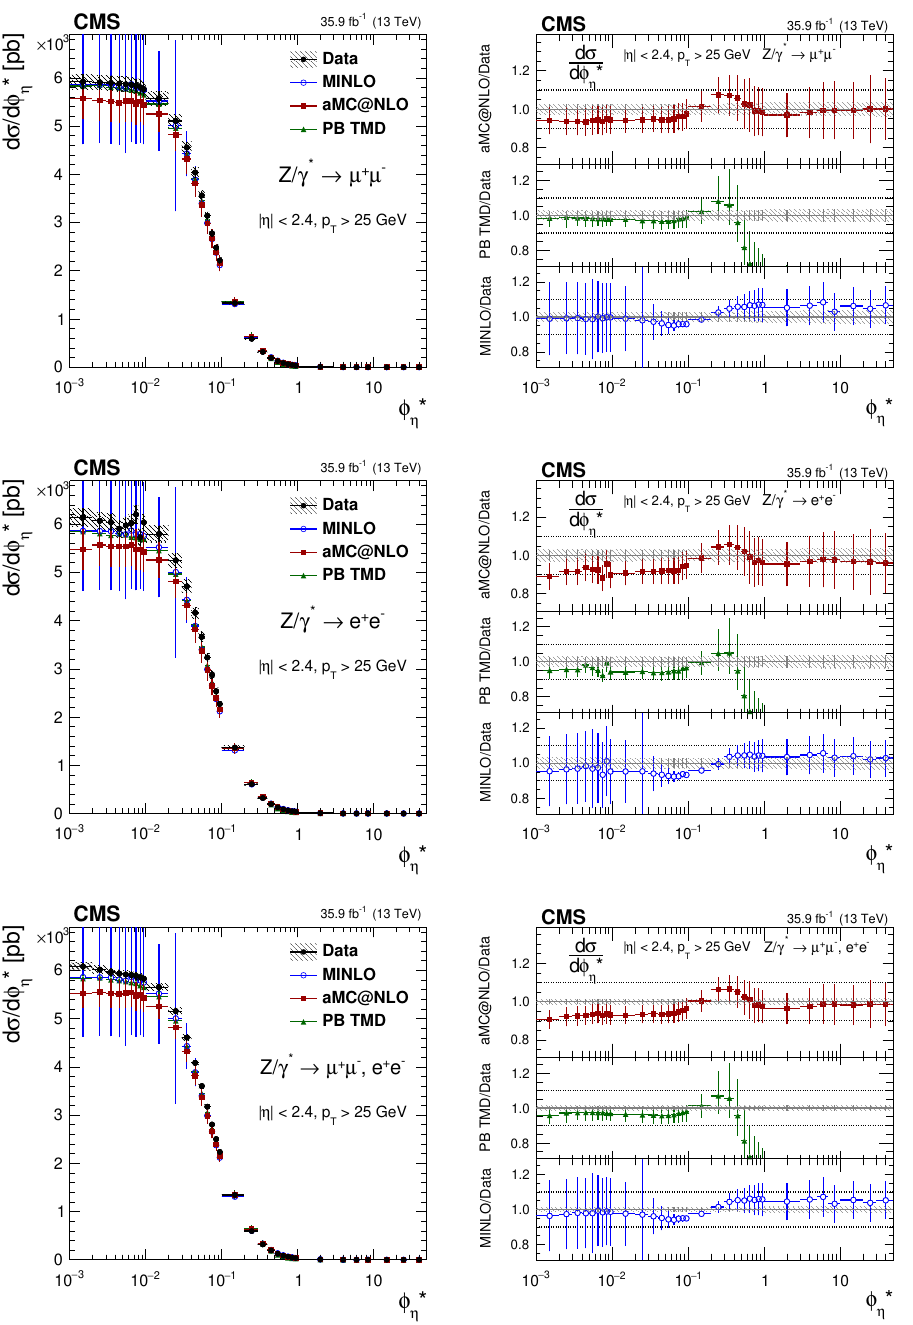
Figure 8 . The measured absolute cross sections (left) in bins of (cid:30) (cid:3) dielectron (middle) (cid:12)nal states, and for the combination (lower). The ratios of the predictions to the data are also shown (right). The shaded bands around the data points (black) correspond to the total experimental uncertainty. The measurement is compared to the predictions with Mad- Graph 5 a mc@nlo (square red markers), PB TMD (green triangles), and powheg - MINLO (blue circles). The error bars around the predictions correspond to the combined statistical, PDF, and scale